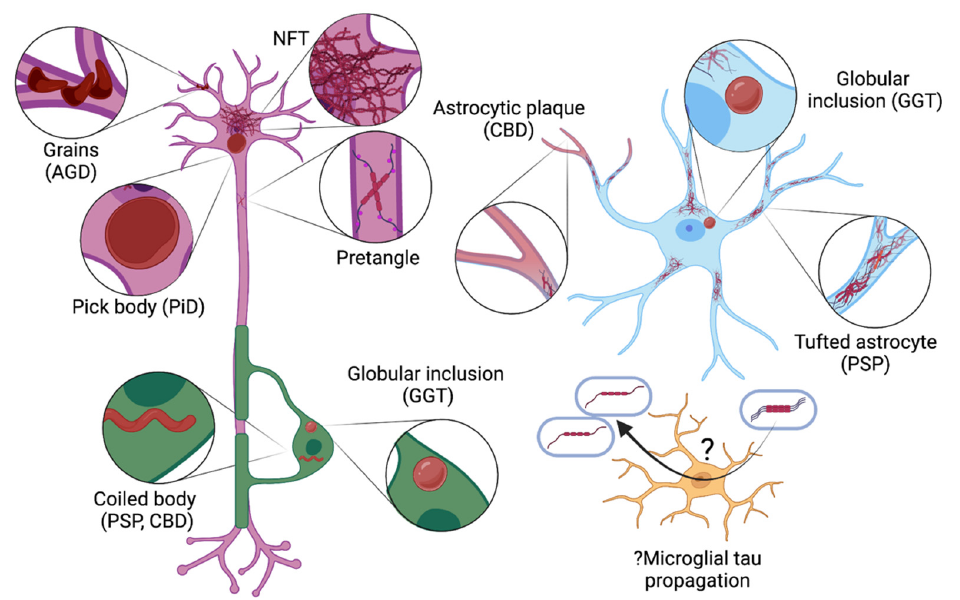
Figure 3. Pathological tau lesions seen in different cell types in tauopathies. In the neuron (purple), tau aggregates include pretangles and neurofibrillary tangles (NFTs), round cytoplasmic inclusions (Pick bodies; typical of Pick disease [PiD]) and grains (dendritic swellings, seen in argyrophilic grain disease [AGD]). Oligodendrocytes (green) may develop tau aggregates in the form of globular inclusions (a feature of globular glial tauopathy [GGT]) or coiled bodies (seen in progressive supranuclear palsy [PSP] and corticobasal degeneration [CBD]). Tau may accumulate in astrocytes (blue) as star-like tufts, plaques, or globular inclusions (hallmarks of PSP, CBD, and GGT, respectively). While pathological tau lesions do not occur in microglia (yellow), they may be implicated in propagating tau (this uncertainty is indicated by the symbol ‘?’). Table 2. Clinical features and tau lesional characteristics of selected tauopathies.